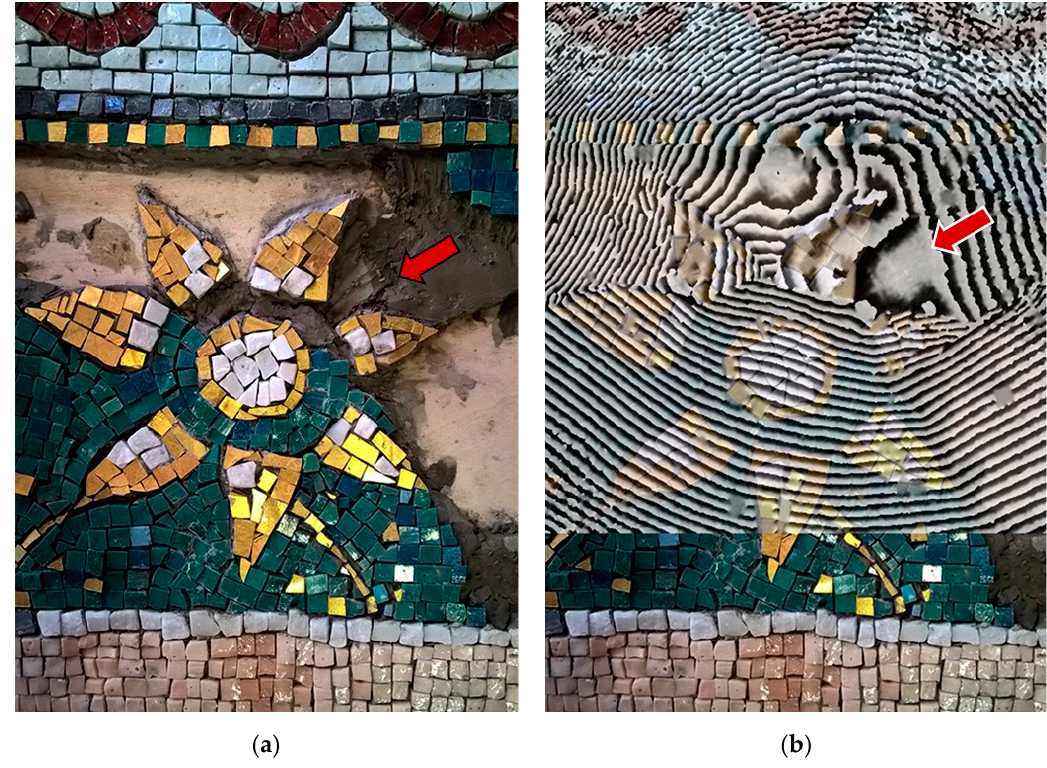
Figure 6. Digital holographic speckle pattern interferometry (DHSPI) results in a custom-built mosaic model. Efficient recognition of mortar inhomogeneity, stitches, and cracks: ( a ) sample preparation in progress, detail of mortar application with a defect; ( b ) Interferogram at 170 s after Δ t = 3.1 °C thermal excitation on a completed mosaic model, overlap with the photographic documentation of the sample preparation (25% transparency mode). After Chaban et al. [73].